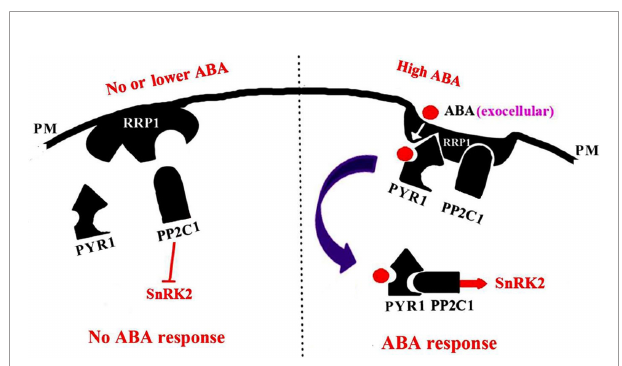
FIGURE 9 | A model for SCD2/RRP1-mediated endocytosis of ABA and ABA signaling. When the ABA content is low or absent, RRP1 may bind to and activate ABI1 activity and, as a result, promote inhibition of SnRK2 activity and ABA response. When the ABA content is high, ABA binds to RRP1 to promote the RRP1 recruitment of PYR1 and ABI1 to the plasma membrane (PM) to form a three-protein complex, which then further facilitates SCD2/RRP1-mediated endocytosis of ABA and ABA